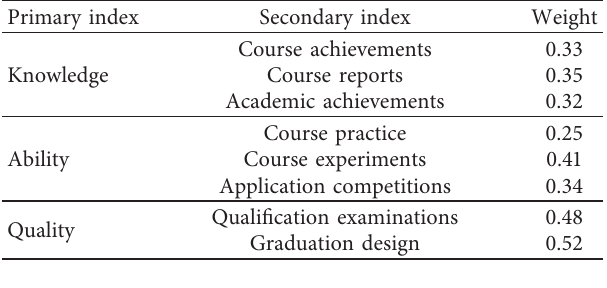
Table 2: Weights of the secondary evaluation